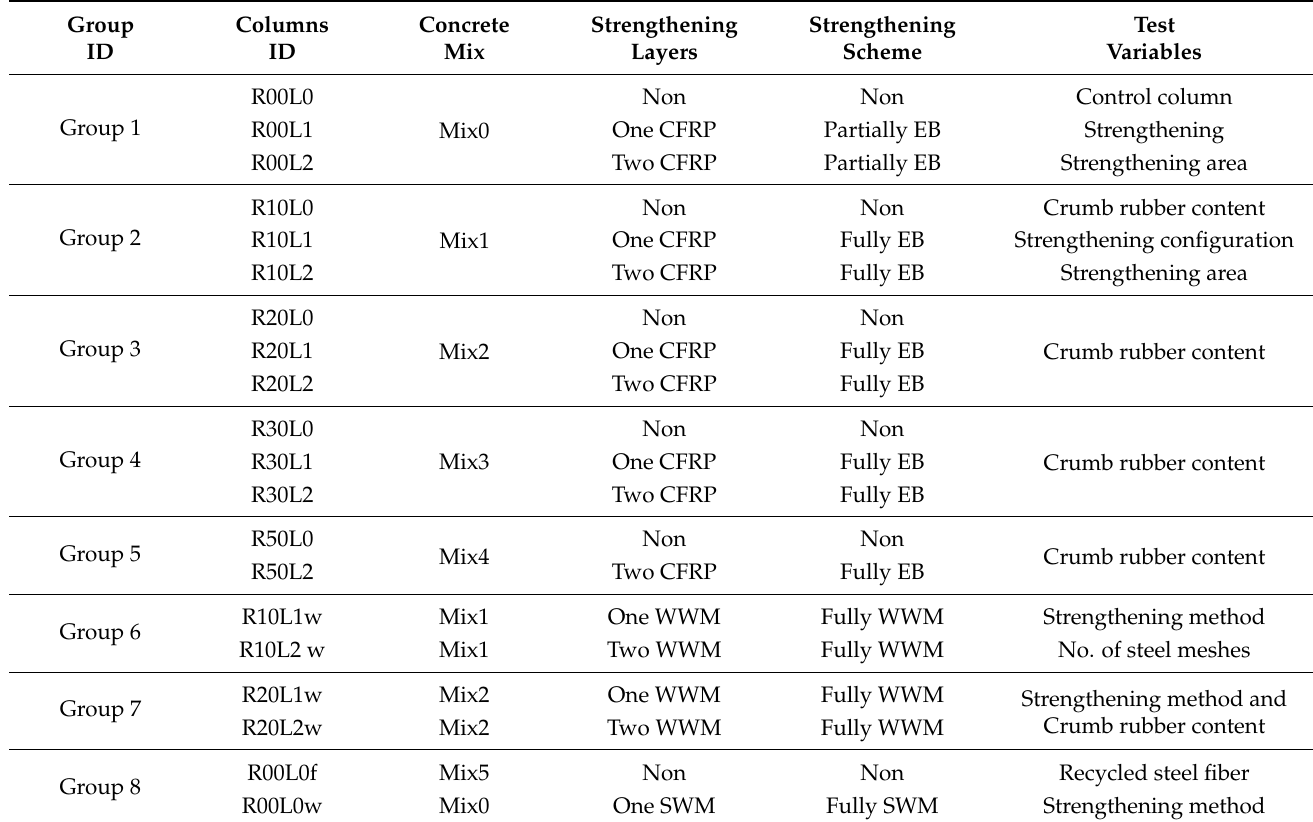
Table 4. The columns’ details and test